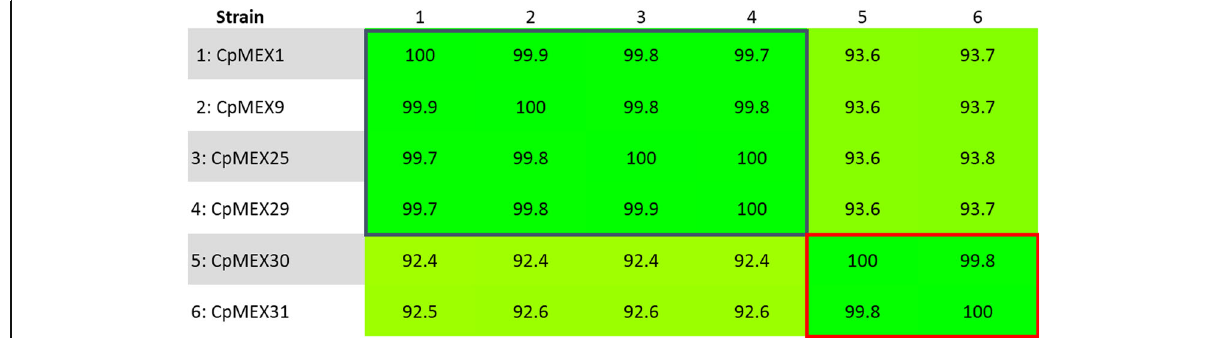
Fig. 4 Alignment generated using Gegenees software showing the percentage similarity among the strains, based on the accessory genome. The blue rectangle highlights the grouping of the biovar ovis . The red rectangle highlights the grouping of the biovar equi